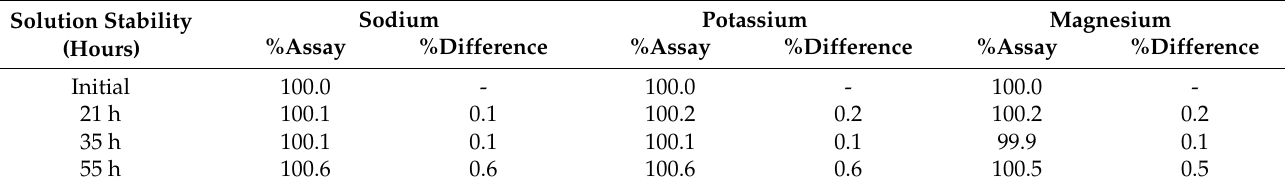
Table 4. Standard solution stability at room temperature.